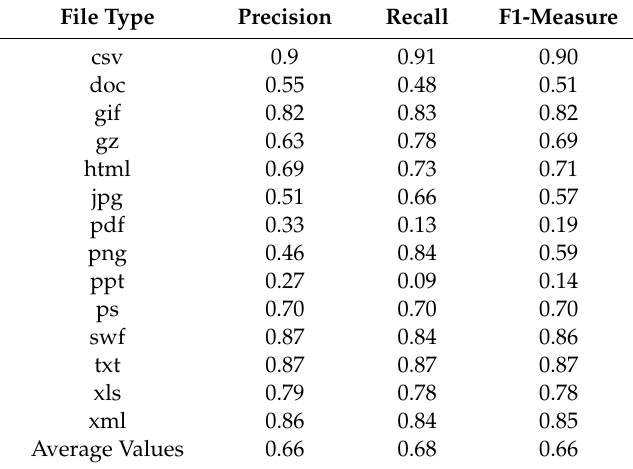
Table 6. Accuracy of 10 folds for C = 75, gamma = 0.0001.